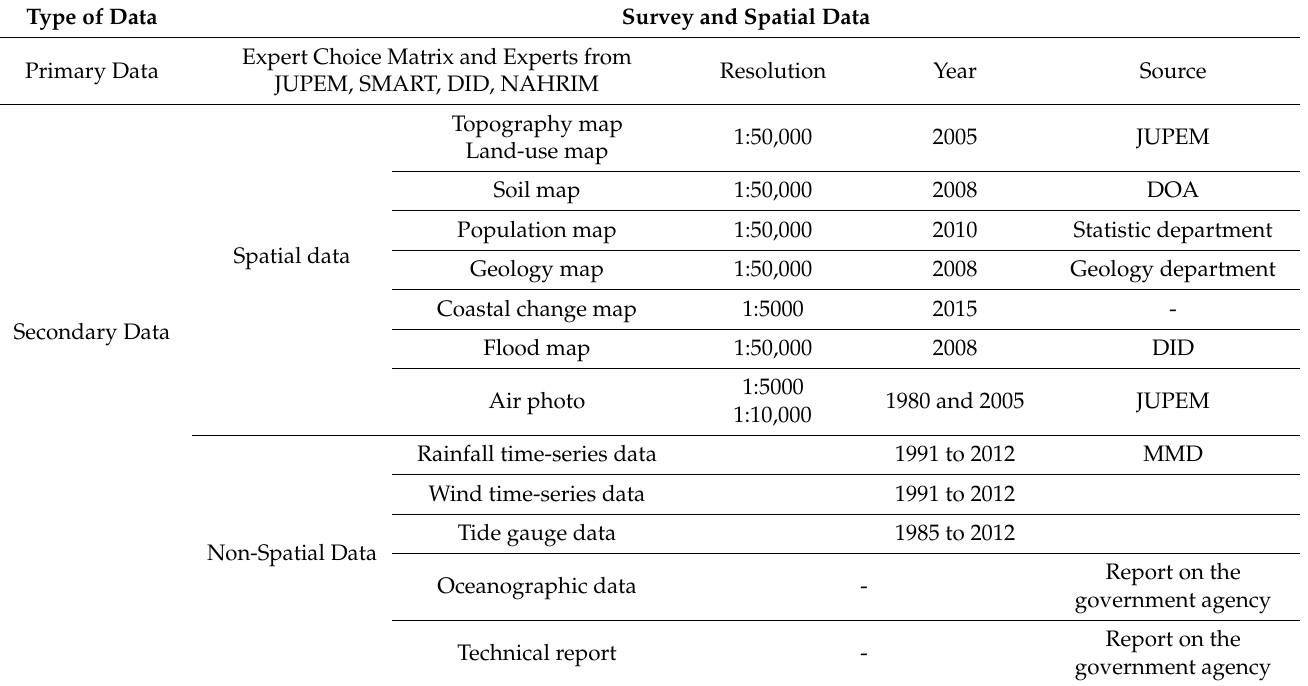
Table 1. Coastal land-use changes spatial and non-spatial